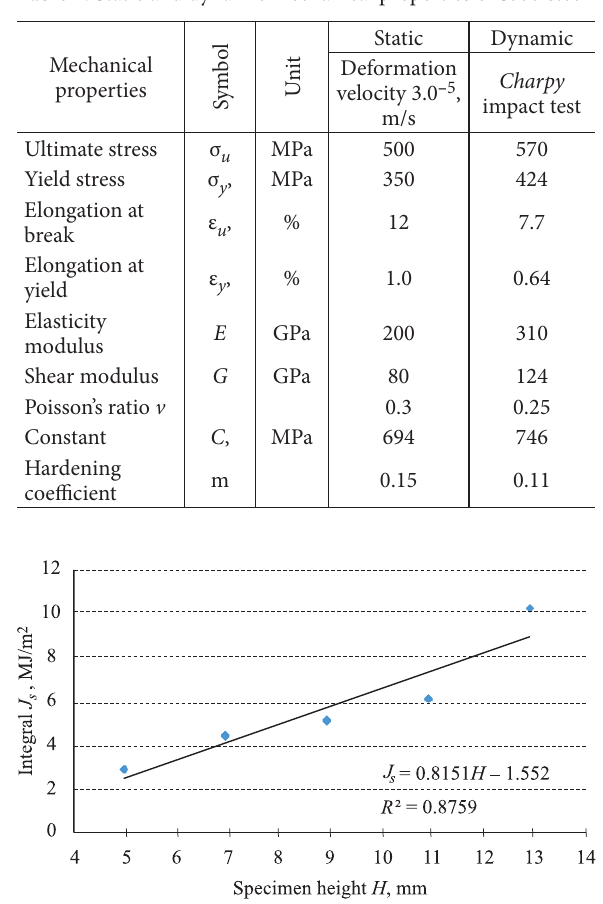
Table 2. Static and dynamic mechanical properties of S355